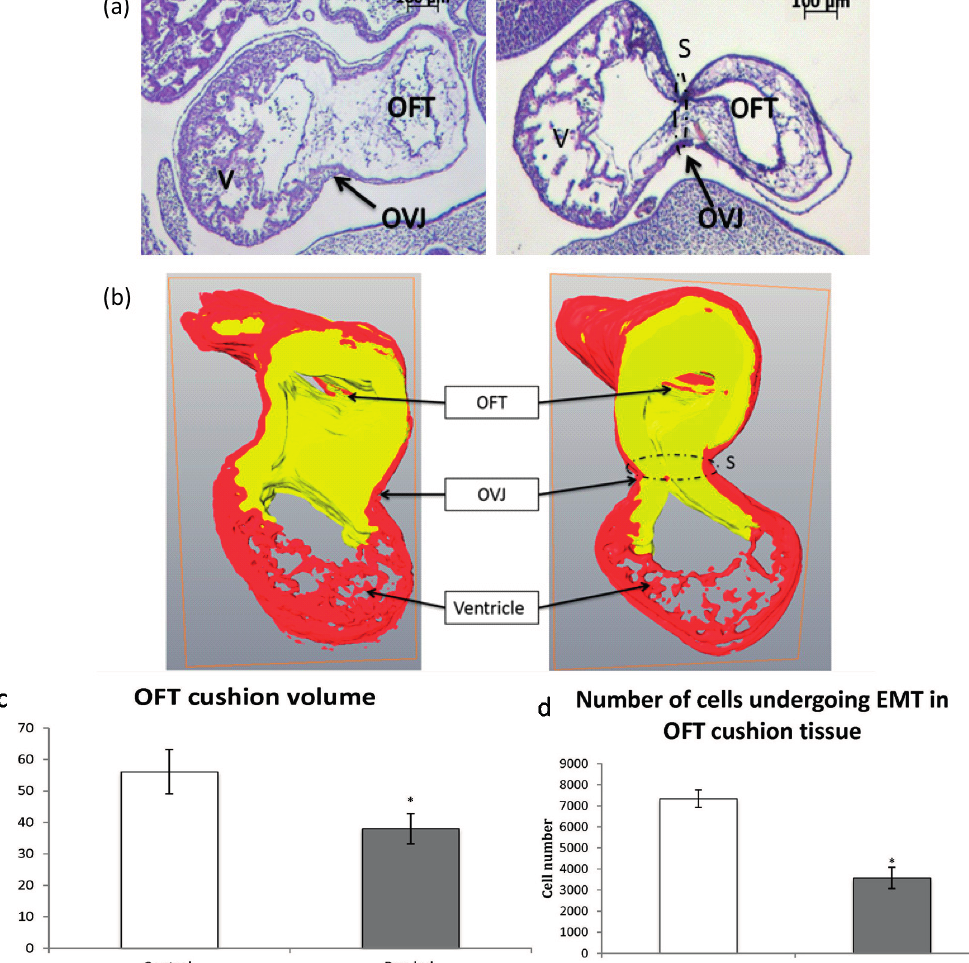
Figure 3. 3D reconstructed OFT. ( a ) Representative H&E-stained images of a control (left) and banded OFT (right); ( b ) cut-away view of a control (left) and banded (right) 3D reconstructed OFT showing cushion (yellow) and myocardium (red). The effect of OFT banding on ( c ) OFT cushion volume and ( d ) the number of cells undergoing EMT. V, ventricle; S, position of suture. * p <